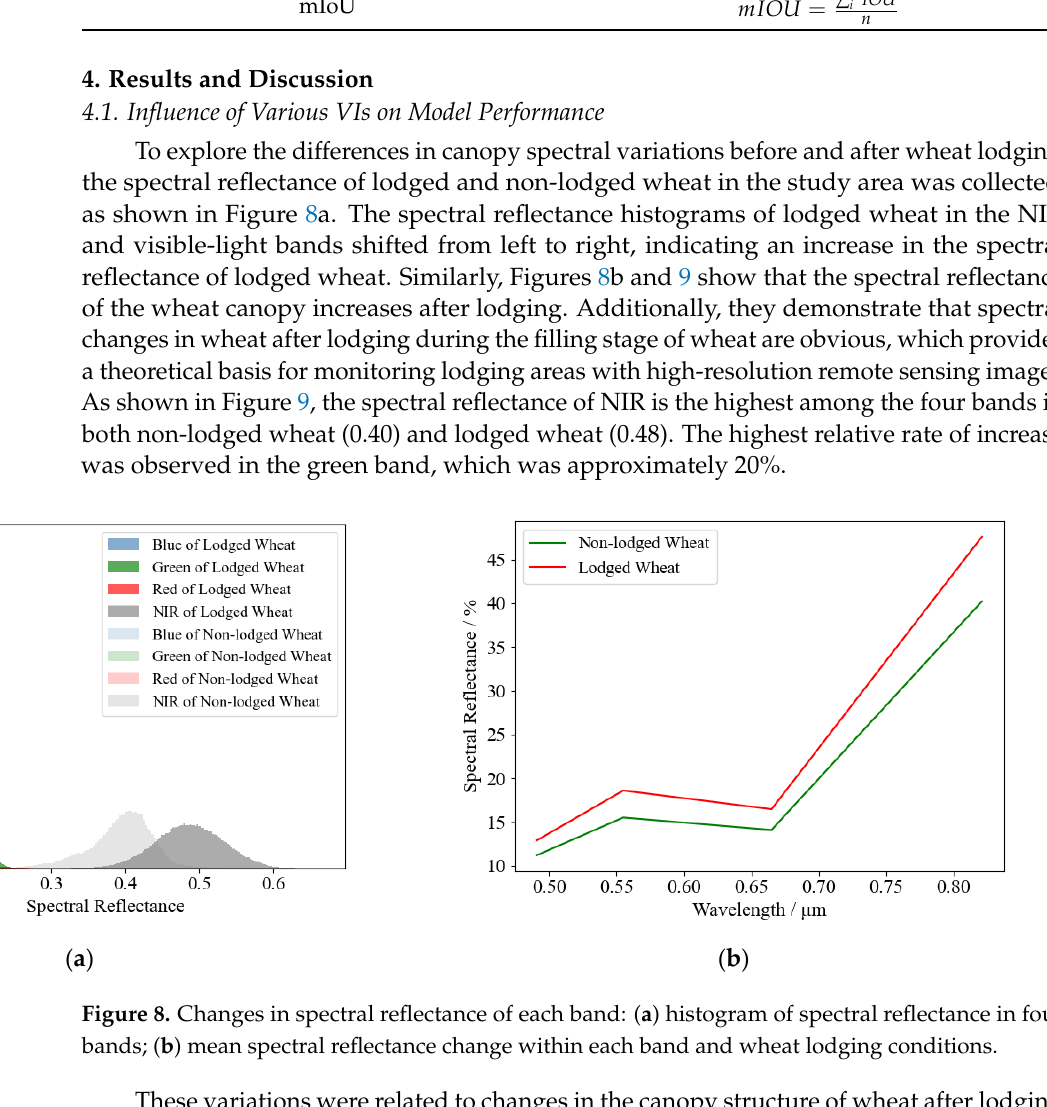
Figure 9. Increment of spectral reflectance of lodged wheat in each band, and relative increase rate of spectral reflectance of each band. These variations were related to changes in the canopy structure of wheat after lodg- ing. A possible reason for this phenomenon is that the spikes and leaves of wheat contrib- uted the most to the canopy spectrum before lodging, while the stalk became the main contributor to the canopy spectrum when lodging occurred, which reduced the shielding of the top leaves; thus, the spectral reflectance increased overall [12,40]. The VIs used in this study were calculated from spectral reflectance. Therefore, changes in vegetation spectral reflectance could result in changes in VIs. Figure 10 com- pares the values of NDVI, GNDVI, EVI, and RVI for lodged and non-lodged wheat. In the case of lodging, the reflectance of four VIs was larger than that of non-lodged wheat. How- ever, no significant reflectance differences were observed between lodged and healthy